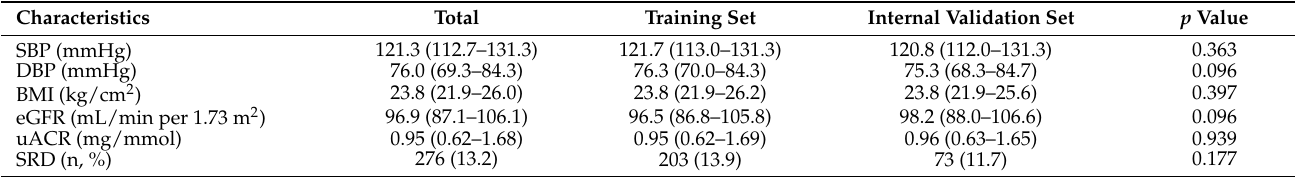
Table 1. Characteristics of the participants in the training and internal validation sets.